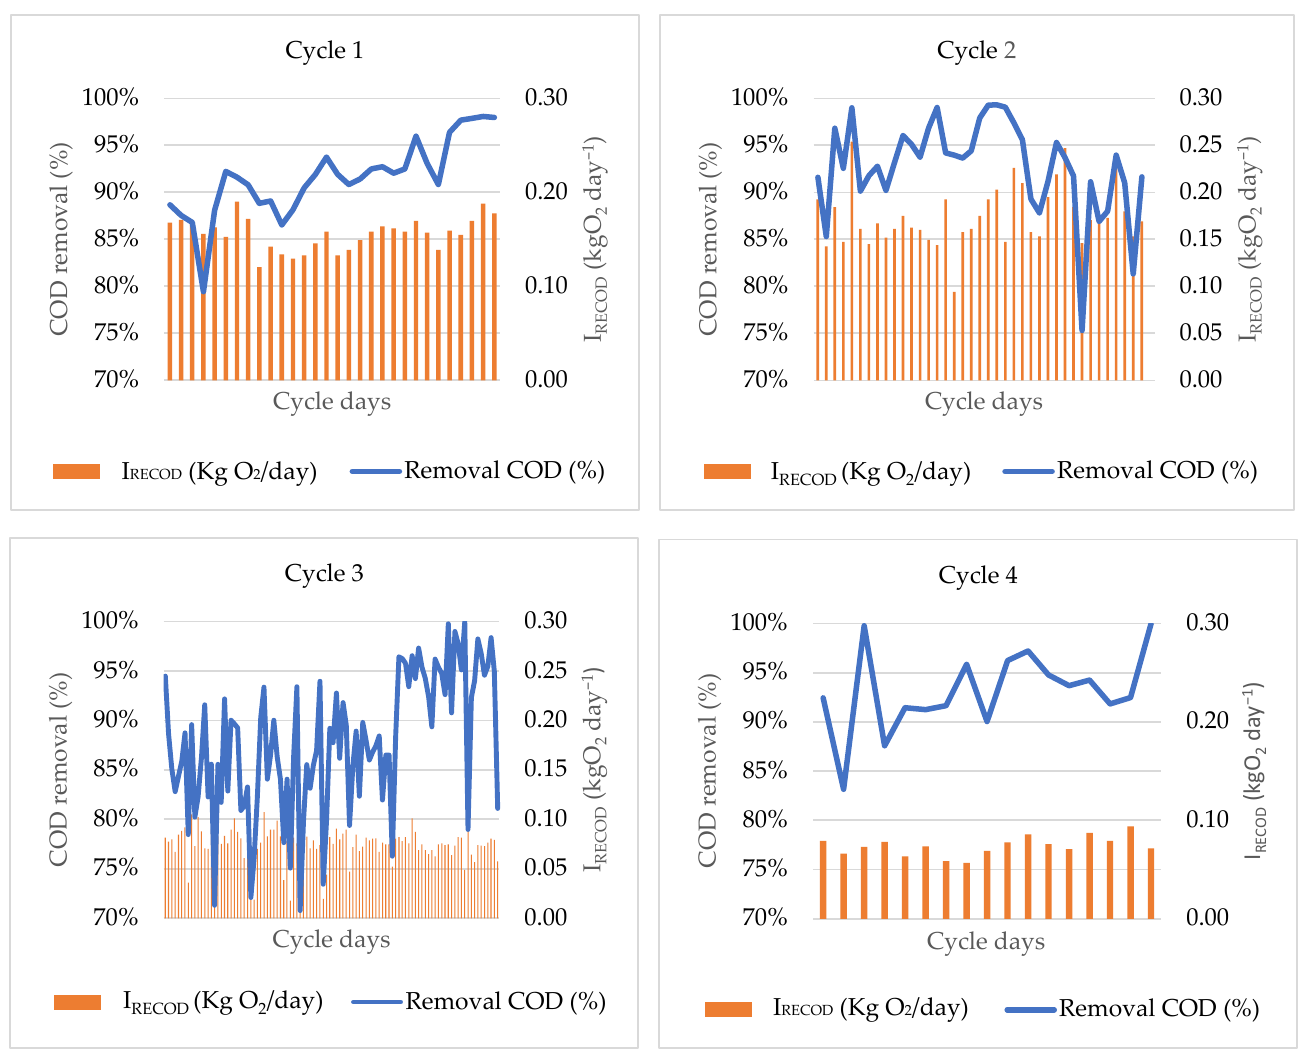
Figure 2. Organic matter removal efficiency indicator (I RECOD ) for operational cycles .